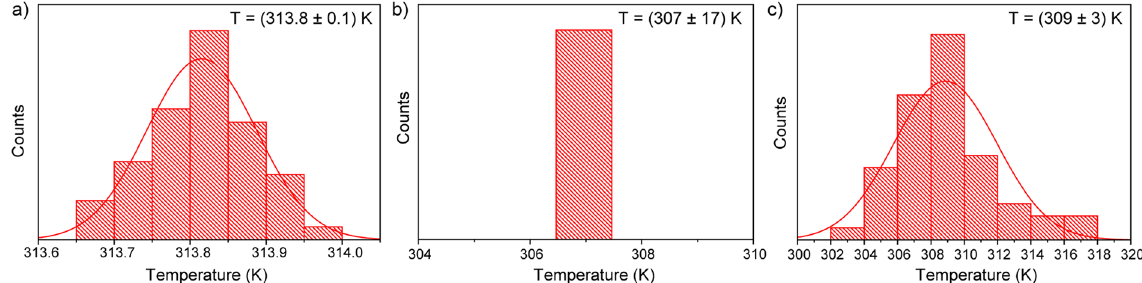
Figure 5. Thermal distributions calculated from ( a ) LIR, ( b ) line position and ( c ) FWHM of YVO 4 :Nd 3 + 2.4 at.% NPs (T heater = 313